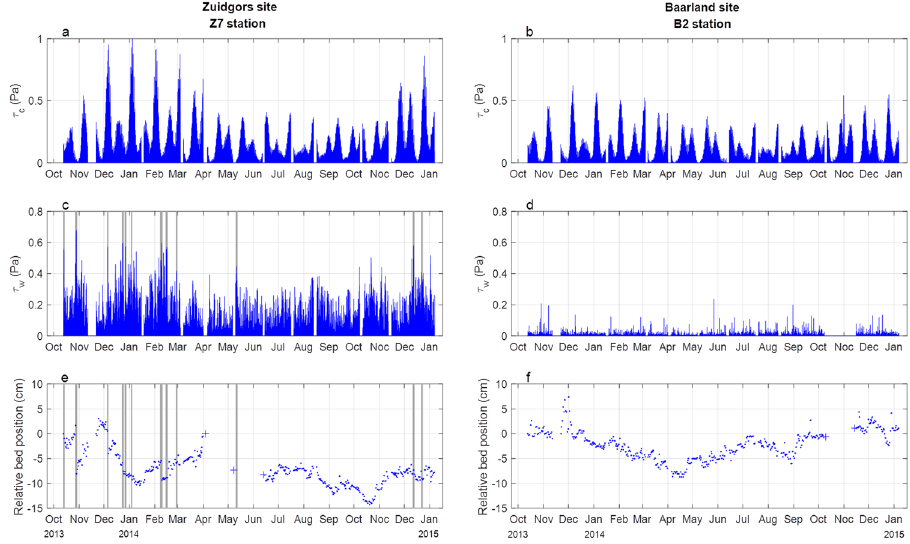
Figure 2. Tidal current induced BSS ( τ c ), wave induced BSS ( τ w ) and daily relative bed positions at the exposed Z7 and sheltered B2 station. τ c and τ w are obtained by hydrodynamic models. The daily bed-level position data is obtained by newly-developed SED-sensors. The bed-level at the start of the measurements is at ‘0’. The positive and negative values indicate deposition and erosion, respectively. When SED-sensor failure leads to no daily bed-level data, the monthly-obtained differential GPS data is used as substitute (the ‘ + ’ sign in panel e and f). The shaded stripes indicate stormy periods, i.e. when the incident significant wave height at the wave-exposed site exceeds 0.5 m (panel c and